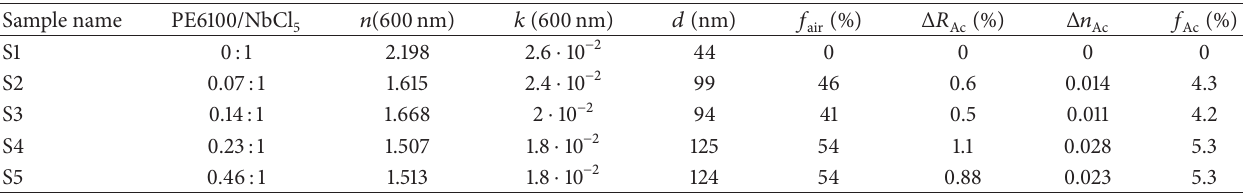
Table 1: Refractive index ( 𝑛 ), extinction coefficient ( 𝑘 ), thickness ( 𝑑 ), volume fractions of air ( 𝑓 , and refractive index change Δ𝑛 change Δ𝑅 Ac